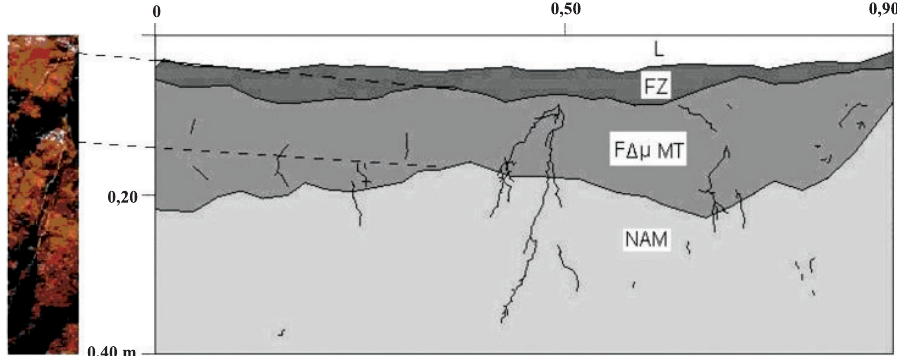
Figura 3. Perfil cultural do solo sob manejo plantio direto. L: livre; FZ: estrutura laminar, com fissuras; F ΔΔΔΔΔ μ mt: em processo de compactação, com fissuras – médios torrões; NAM: não alterado pelo manejo.